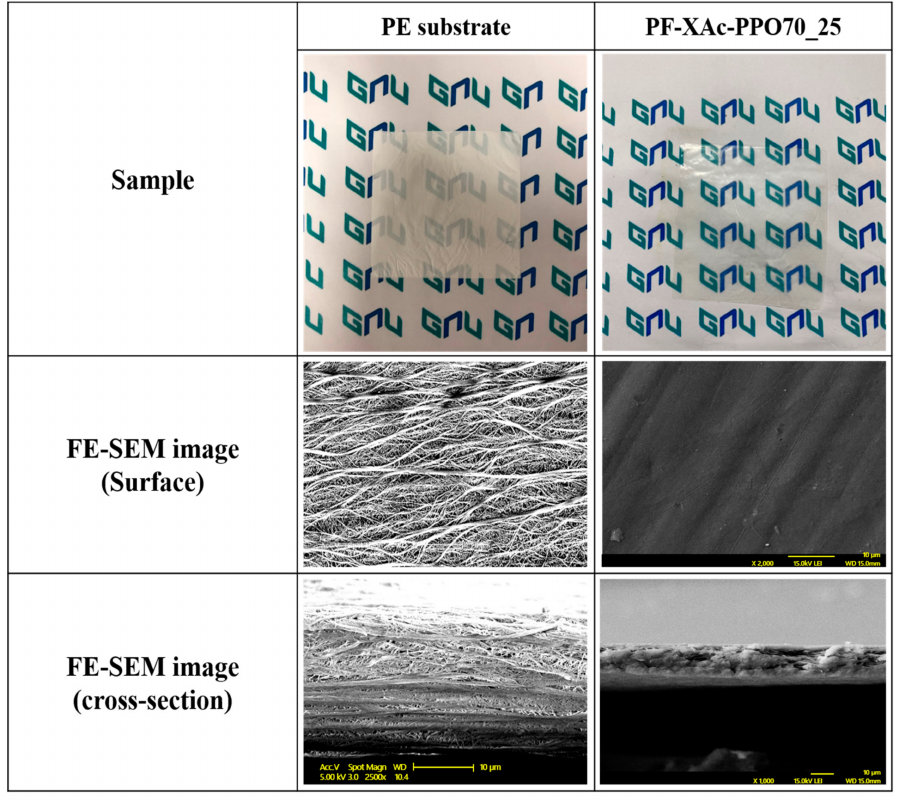
Figure 4. FE-SEM images of the surface and cross–section of the porous PE support and crosslinked pore-filling membrane (PF-XAc-PPO70_25).